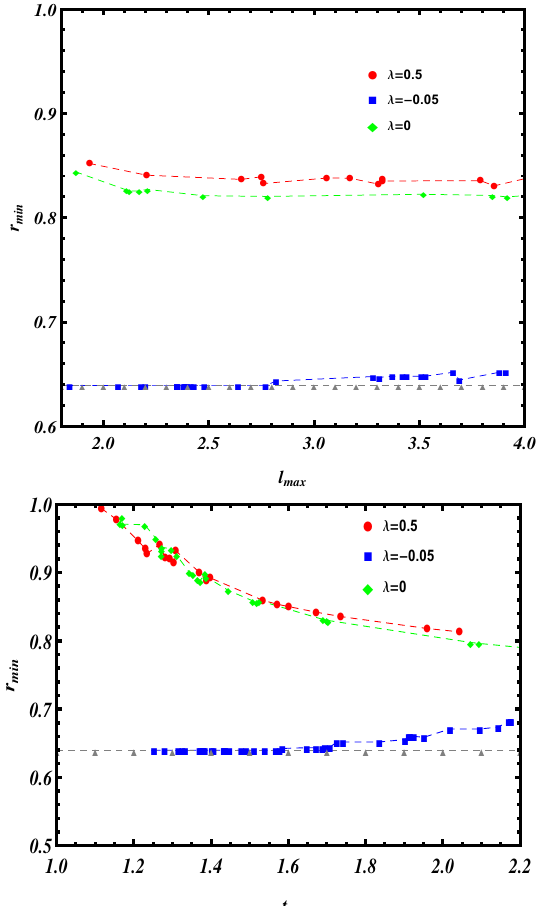
Figure 4 . The minimum point reached by a given entanglement entropy surface for Einstein gravity ( SAdS ), green, (cid:21) GB > 0, red, and (cid:21) GB < 0, blue. Top panel: r min as function of the boundary separation ‘ . Bottom panel: r min as function of the boundary time t b .